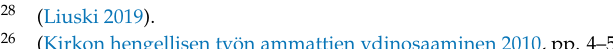
Figure 2. The importance of chaplains’ work sections from a military chaplain’s point of view.